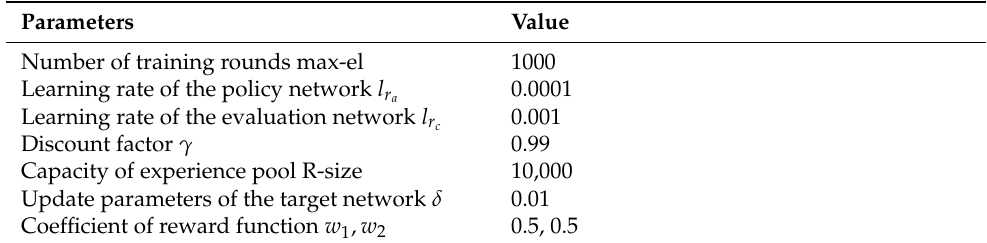
Table 2. Parameter setting of DDPG algorithm.